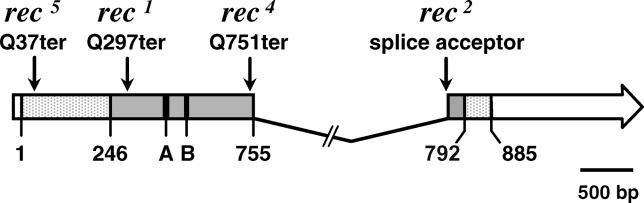
Mutations in rec
The rec gene contains two exons and an intron. Untranslated regions are open and protein-coding regions are filled, with the MCM core indicated by gray fill. Amino acid numbers are shown below the model, and the positions of the four mutations sequenced are shown above. The locations of the Walker A and B boxes are shown as black bars and are labeled below the model. Only the position of the intron is indicated. The full intron is 5.5 kilobases and contains another predicted gene (CG4576), transcribed in the opposite direction.